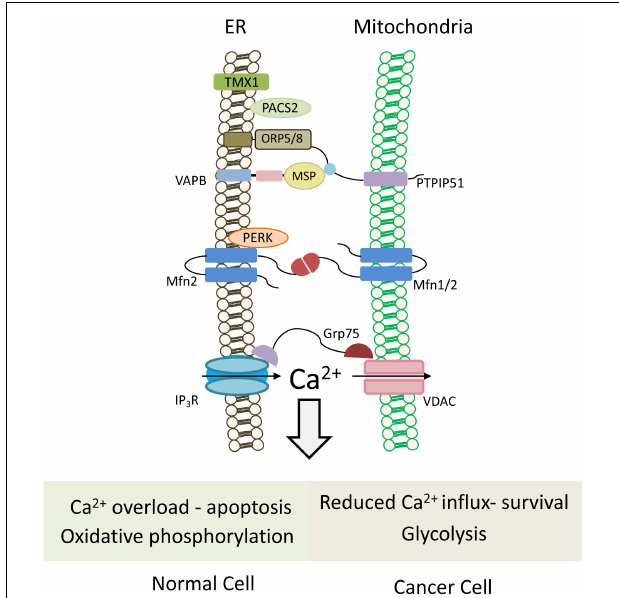
FIGURE 5 | Mitochondria-associated ER membranes in normal versus cancer cells. Schematic cartoon illustrating ER-mitochondria (MAMs) tethering proteins. MAMs regulate lipid transfer and play an important role in Ca 2 + homeostasis by orchestrating Ca 2 + shuttling from ER to mitochondria. Normal cells rely on oxidative phosphorylation for energy production, and possess normal MAM configuration, which promotes apoptotic cell death in response to calcium overloading. Conversely in cancer cells, which use the glycolytic pathway to produce ATP, expression level of tethering proteins is altered and “aberrant” MAMs are formed. In most cases, the ER-mitochondria contact is reduced and, hence, also the mitochondrial calcium uptake, favoring cell survival and resistance to chemotherapeutic drugs. Multiple proteins are involved in ER-mitochondria tethering (Sassano et al., 2017), those that are described in the text and the figures are: TMX1, thioredoxin related transmembrane protein 1; PTPIP51, protein tyrosine phosphatase-interacting protein 51; VAPB, VAMP-associated protein B; Mfn1/2, Mitofusin 1/2; PERK, protein kinase RNA-like ER kinase; GRP75, glucose-regulated protein 75; IP 3 R, IP3 (inositol 1,4,5-trisphosphate) receptor; VDAC, voltage-dependent anion channel; PACS2, phosphofurin acidic cluster sorting protein